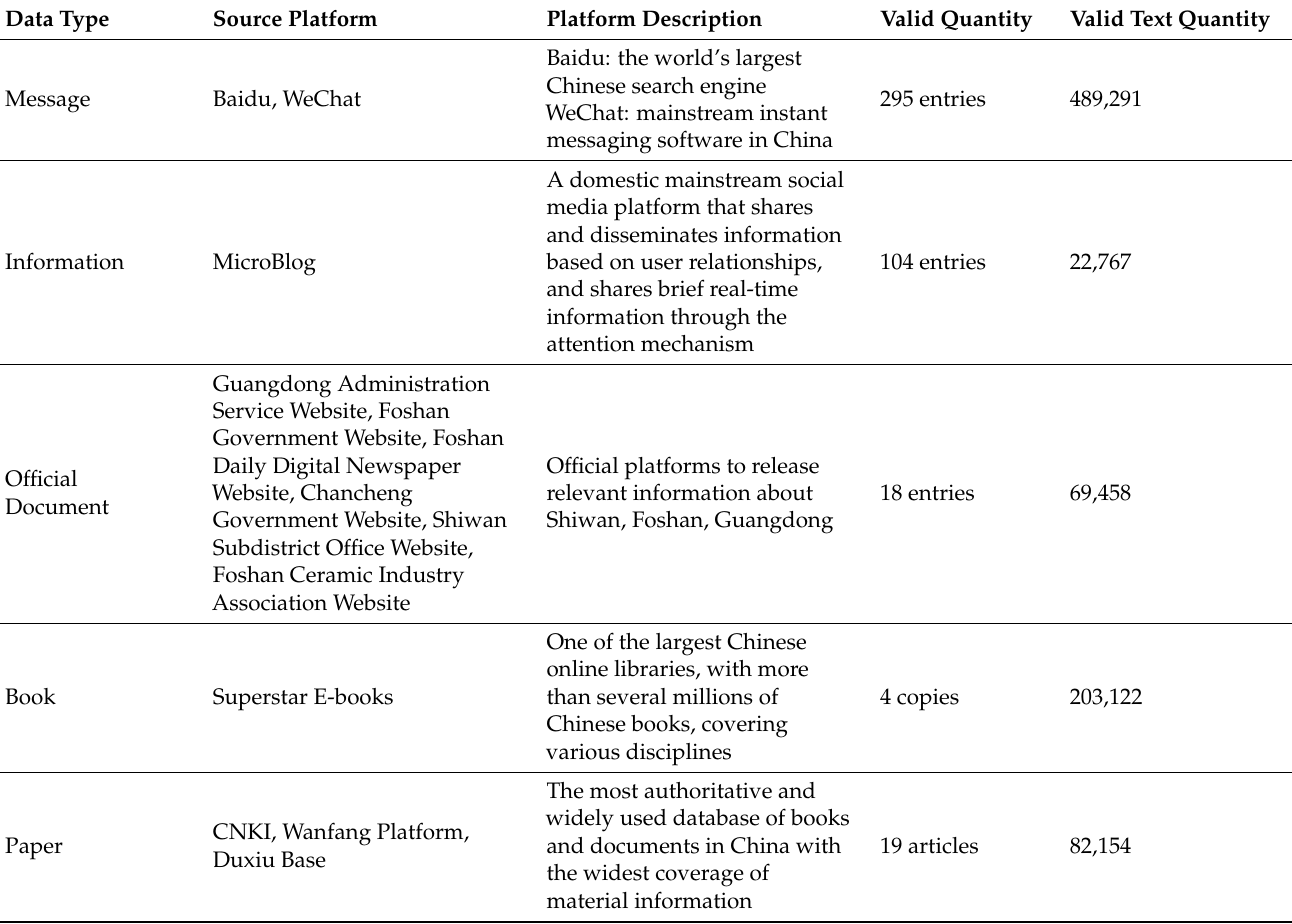
Table 1. The data source and effective quantity description of Shiwan pottery sculpture technique since